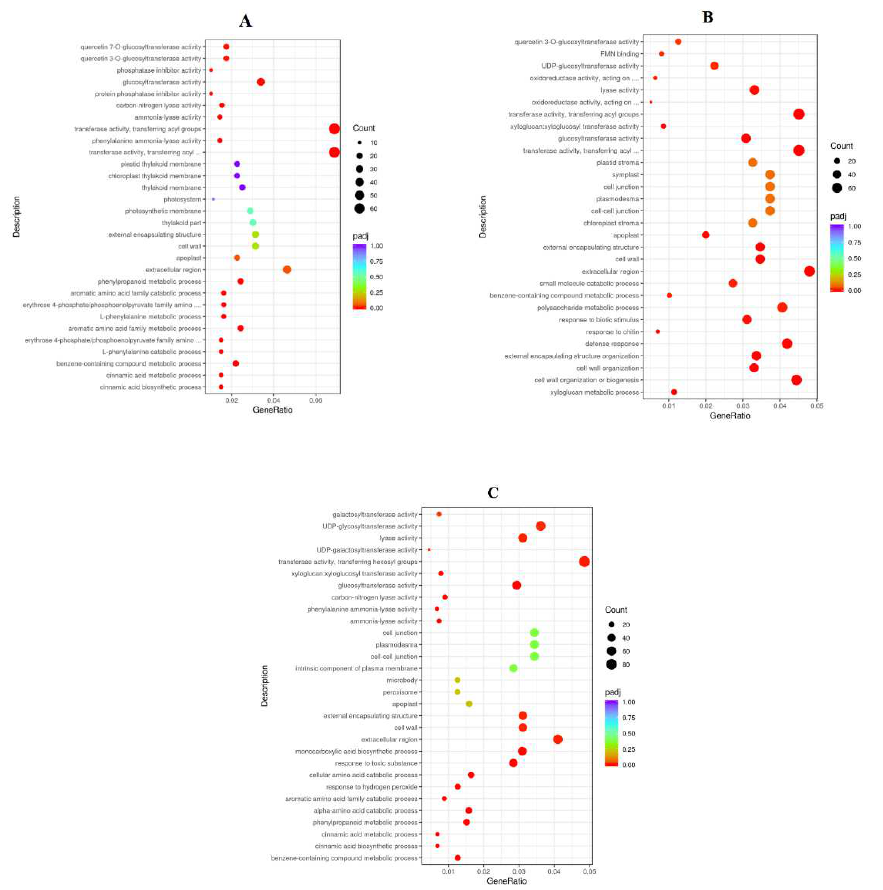
Figure 8. Go enrichment analysis of differentially expressed genes at 78 DAB (( A ): E vs. G, ( B ): F vs. G, ( C ): H vs. G).